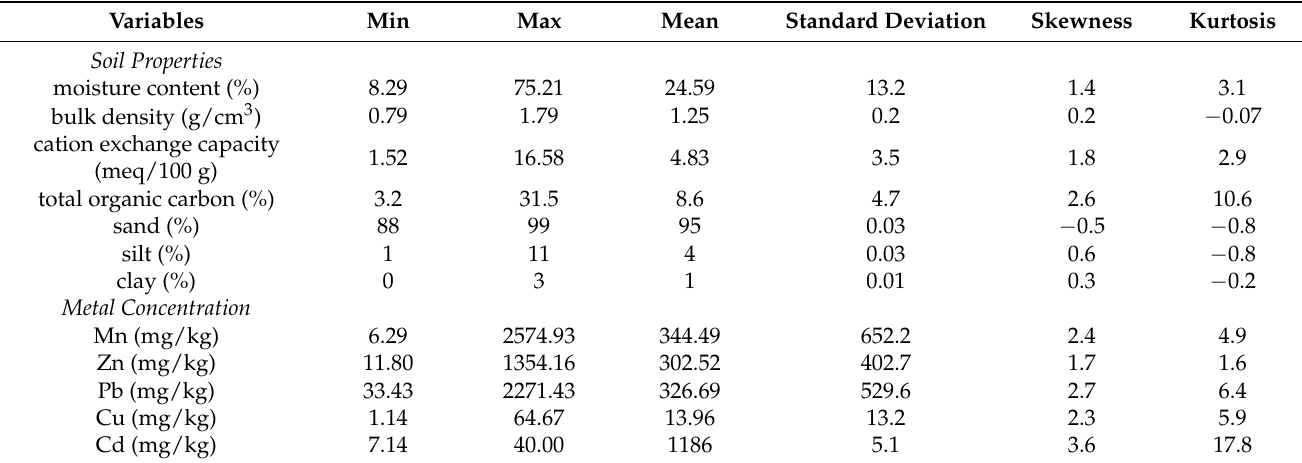
Table 2. Descriptive statistics of soil properties [22].